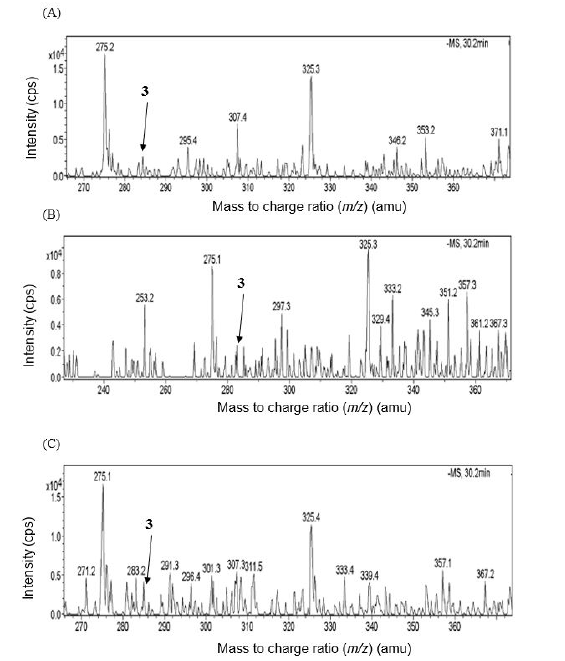
Figure 8. ESI-MS analysis of kaempferol in E. sonchifolia . 3. kaempferol, with m/z 285 [M-H] - , indicated above at retention time 30.2. (A) control plants, (B) heat-stressed plants, and (C) drought-stressed